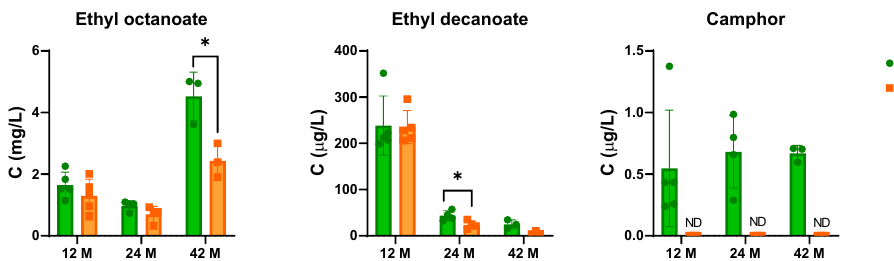
Figure 2. Bar graphs representing the levels of volatile compounds significantly changing in sparkling wine #2 sealed with a sparkling cork with two natural cork discs (2D in green) and a microagglomerated cork (MA in orange) during bottle aging (12 to 42 months). *— p ≤ 0.05, ND—not detected. Table 2. Levels of volatile compounds significantly changing in sparkling wine #2 sealed with a sparkling cork with two natural cork discs (2D) and a microagglomerated cork (MA) during bottle aging (12 to 42 months).